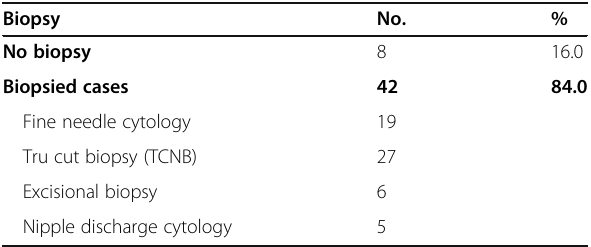
Table 3 Distribution of the studied cases according to